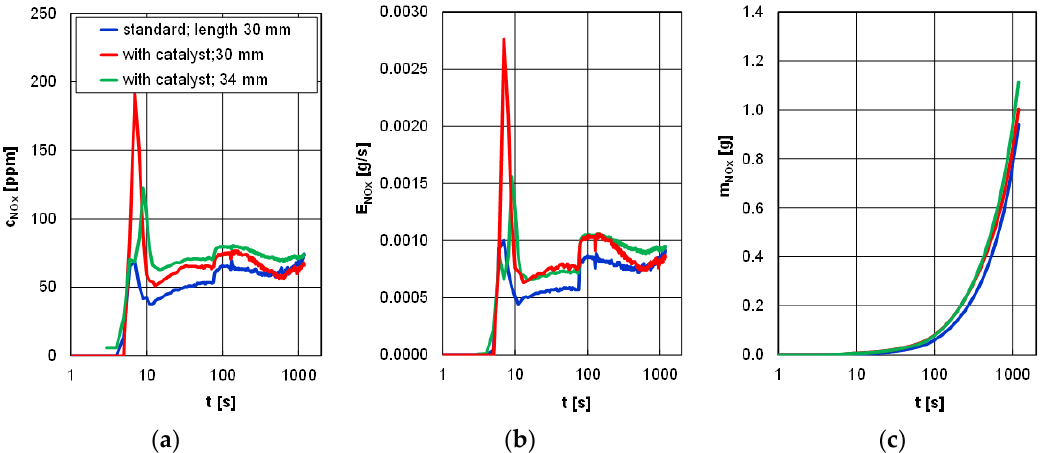
Figure 10. Concentration ( a ), emission rate ( b ), and emission of nitrogen oxides ( c ) during the tests of a diesel engine depending on the type of glow plugs and the length of the catalyst-covered ones.